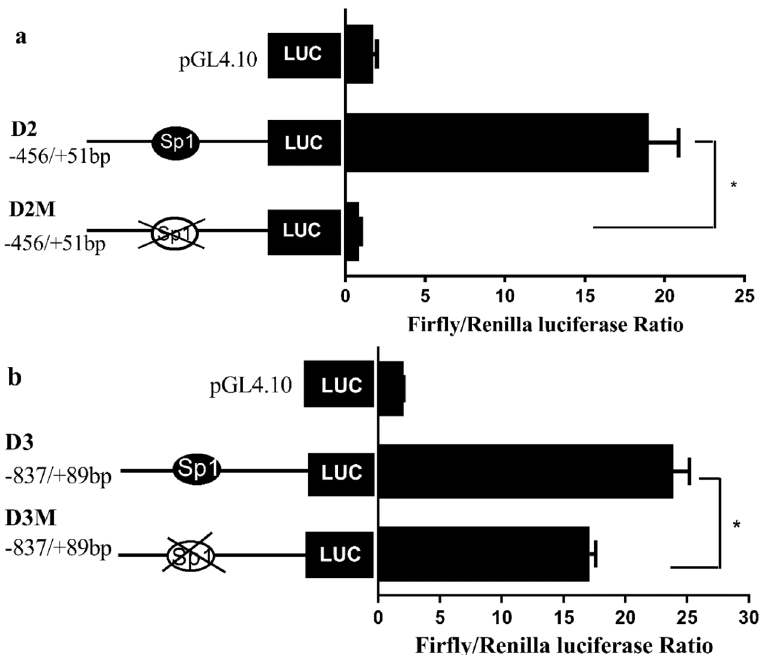
Figure 5. The nucleotide sequence and predicted binding sites for Sp1 in the core region of rabbitfish Δ 6/ Δ 5 fads2 ( a ) and elovl5 ( b ) promoters. Numbers are given relative to the first base of the transcription start site (TSS, +1). Potential transcription binding motifs are marked in black or open boxes for Sp1. The bases underlined are downstream sequence of TSS.